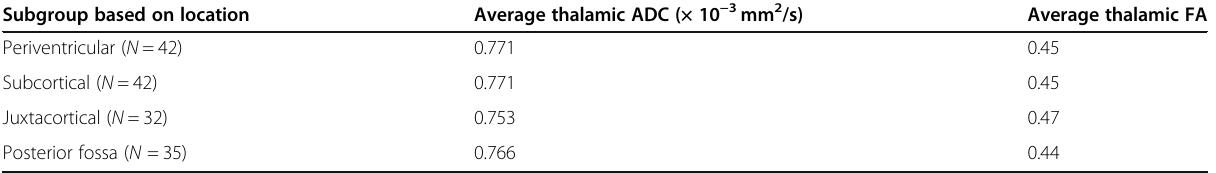
Table 2 ADC and FA of the thalami in the subgroups according to the location of the lesions Subgroup based on location